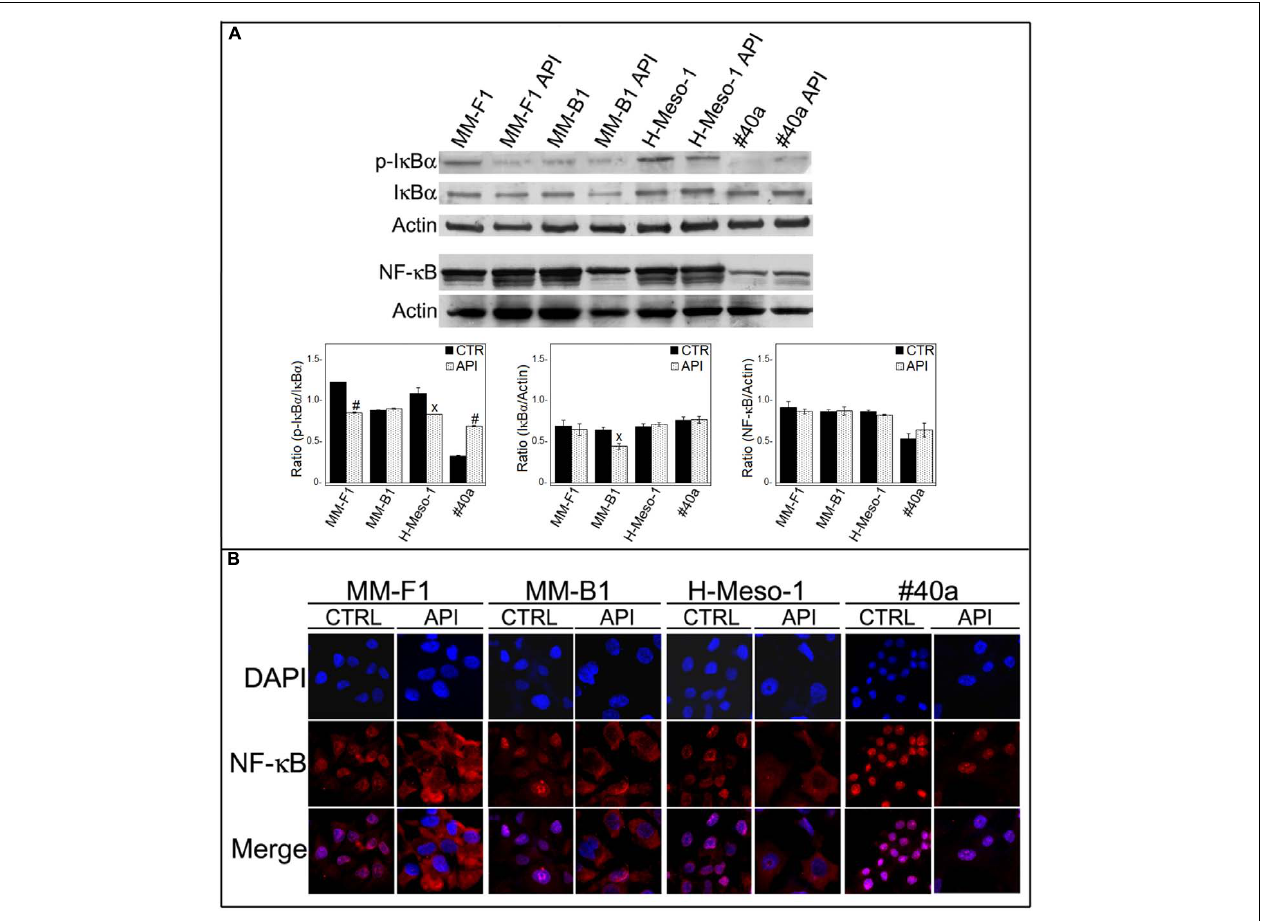
FIGURE 9 | Effect of API on NF- κ B activation. (A) Western blotting analysis was performed on MM cells treated with API at 50 µ M or with the DMSO vehicle (CTR) for 24 h. The densitometric ratios between NF- κ B and actin, I κ B α and actin, p-I κ B α and I κ B α and statistical analysis are reported. Data are expressed as the mean ± SD of two independent experiments ( x p ≤ 0.05, # p ≤ 0.001 compared with CTR). (B) Inhibition of nuclear translocation of NF- κ B after treatment with API in MM cells was assessed by immunofluorescence analysis. Cells were fixed after treatment, and incubated with the anti-NF- κ B antibody. After two washes with PBS, the cells were incubated with the goat anti-mouse IgG Alexa fluor-488-conjugated secondary antibody. Nuclei were stained with DAPI. Original magnification